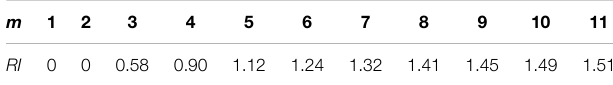
TABLE 4 | Values of mean random consistency index RI .